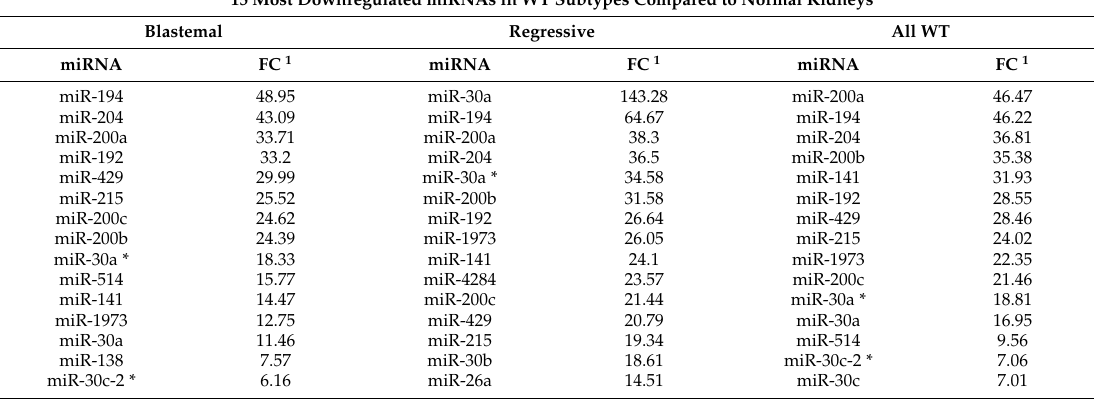
Figure 2. Venn diagram of ( A ) up- and ( B ) down-regulated miRNAs in Wilms tumors (WT) compared to normal kidneys. Table 1. Deregulated miRNAs in Wilms tumors (WT) tissue compared to normal kidneys. 15 Most Downregulated miRNAs in WT Subtypes Compared to Normal Kidneys Blastemal Regressive All WT